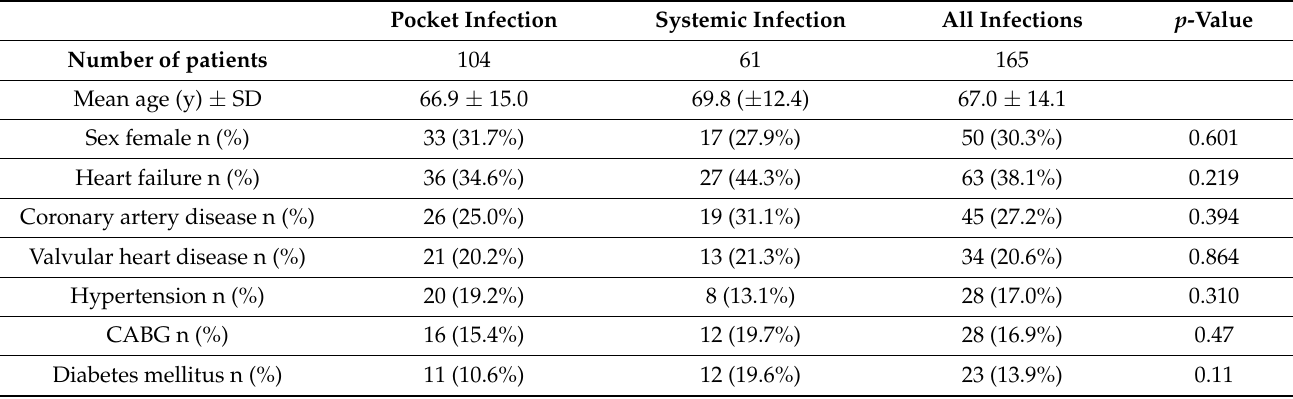
Table 1. Baseline data for 165 patients who underwent removal for CIED infection in 2006–2015 at Karolinska Univer- sity Hospital.